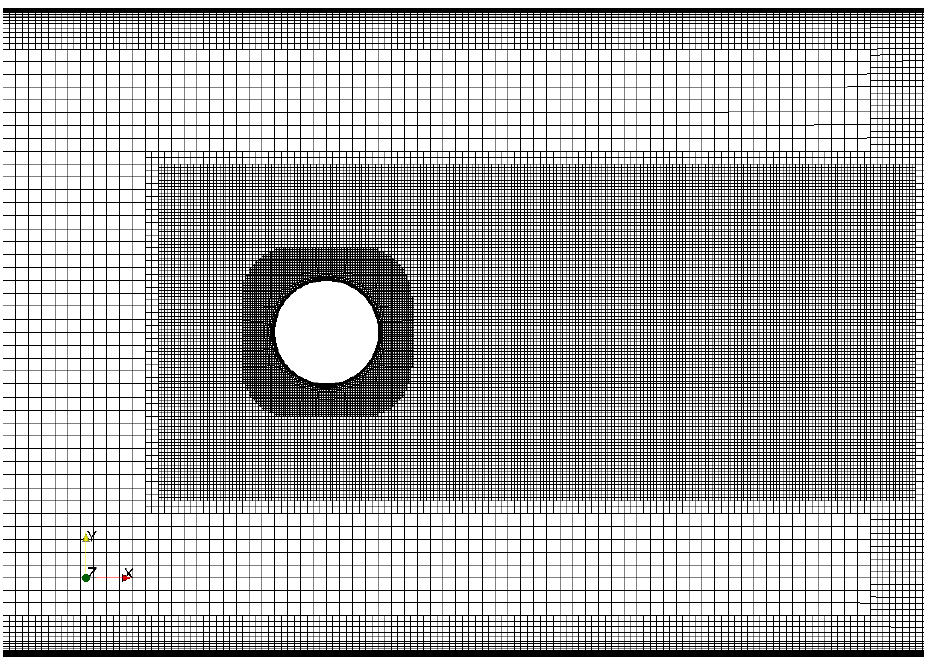
Figure 2. A block-structured